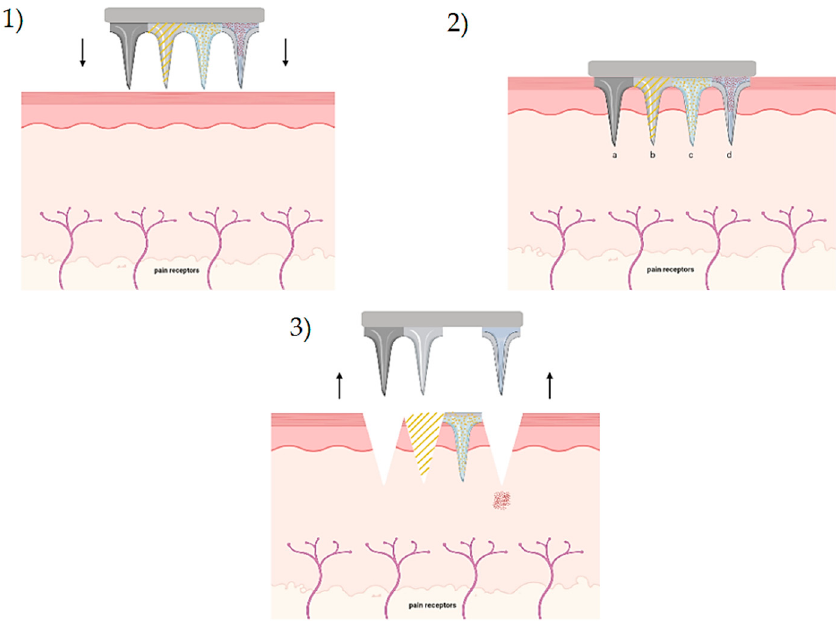
Figure 4. ( 1 ) Application of microneedles, ( 2 ) insertion, ( 3 ) extraction. Types of microneedles: (a) solid microneedles, (b) coated microneedles, (c) dissolving microneedles, and (d) hollow mi-